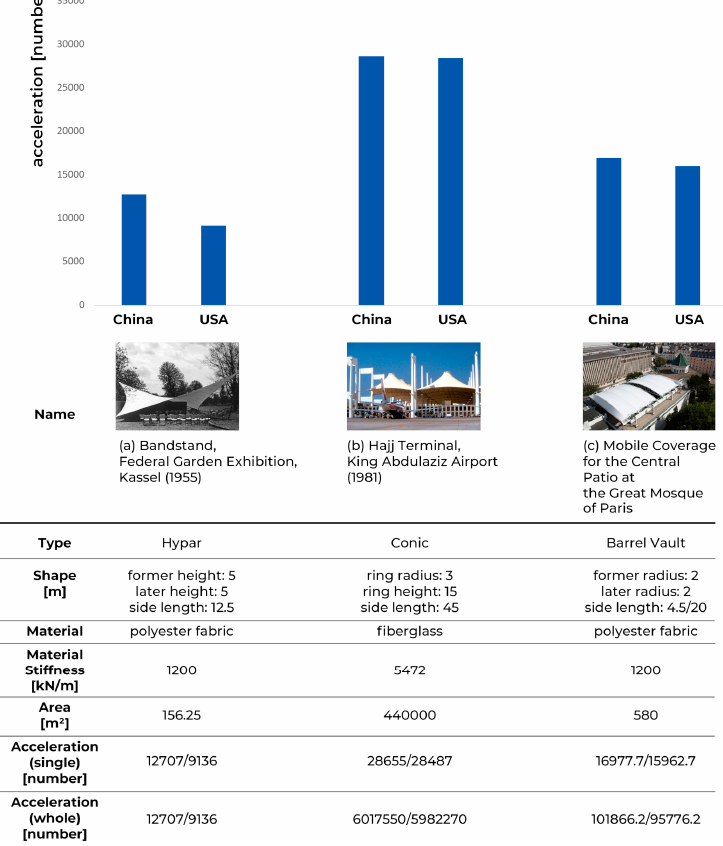
Figure 7. Three existing TMAs.